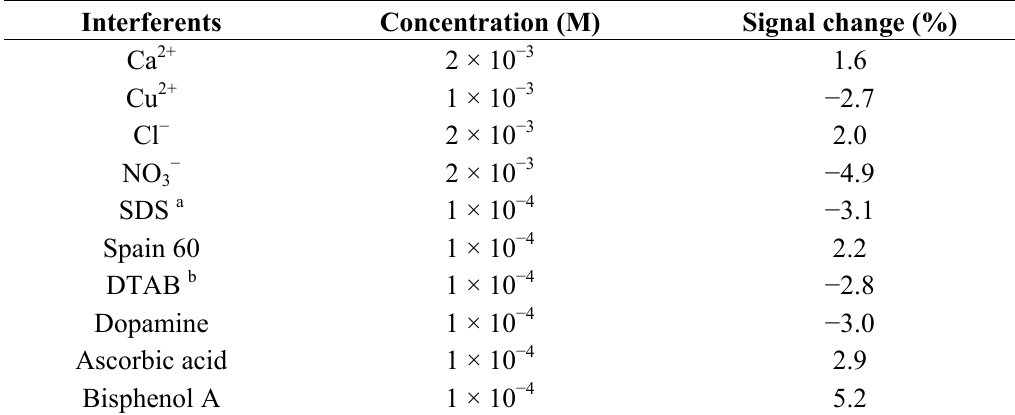
Table 1. Interferences of other species on 2.0 × 10 − 5 M NP.